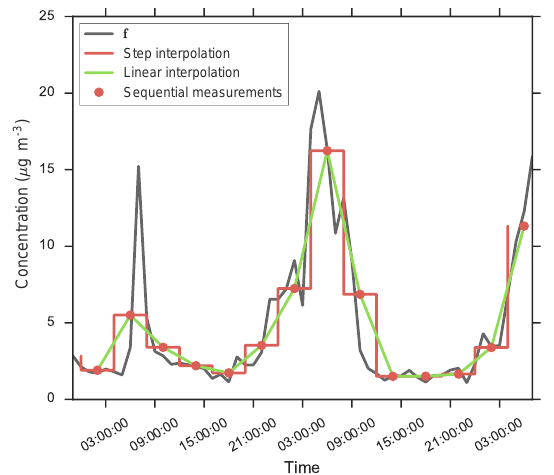
Figure 4. An original time series f of period T = 12h measured with 4h samples ( (cid:49)τ = 4h) staggered at intervals of 1h ( δτ = 1h). The resulting smeared signal g is the full convolution product of f and a convolution matrix H ((cid:49)τ,δτ) . Since f contains 12 data points, g contains 15 ( = 12 + ( 4 / 1 ) − 1 ) data points. The values at the boundaries of g correspond to partial averages of f (sam- ples with sampling time < (cid:49)τ ). In practice these values are often not accessible for measurement, and one is left with a truncated measurement vector g t consisting of only eight ( = 15 − 2 ( 4 − 0 . 5 )) data points. The truncated measurement vector can be padded on its edges by the uniform ( g uni ) or reflective ( g ref ) methods so that is has the same number of elements as the full convolution product g